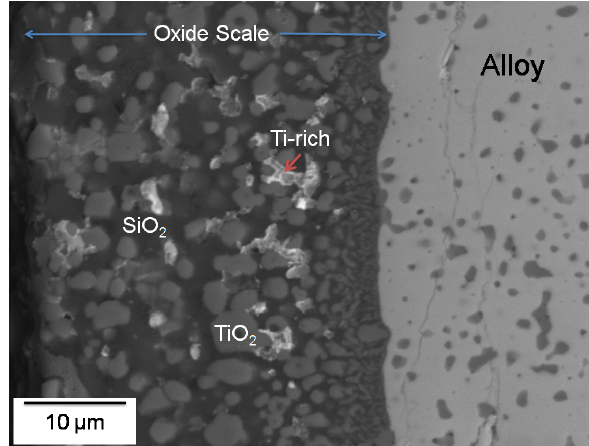
Figure 6: Scale thickness ( h ) vs t 1/2 plots confirming parabolic growth kinetics of the oxide scale.